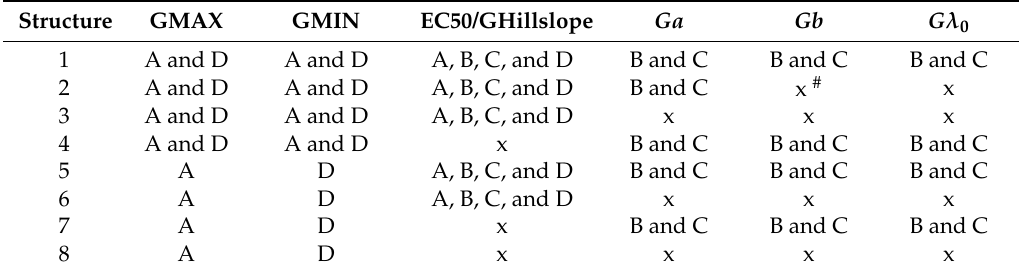
Table 2. The ways or sources of the generalized parameters of GLGCM